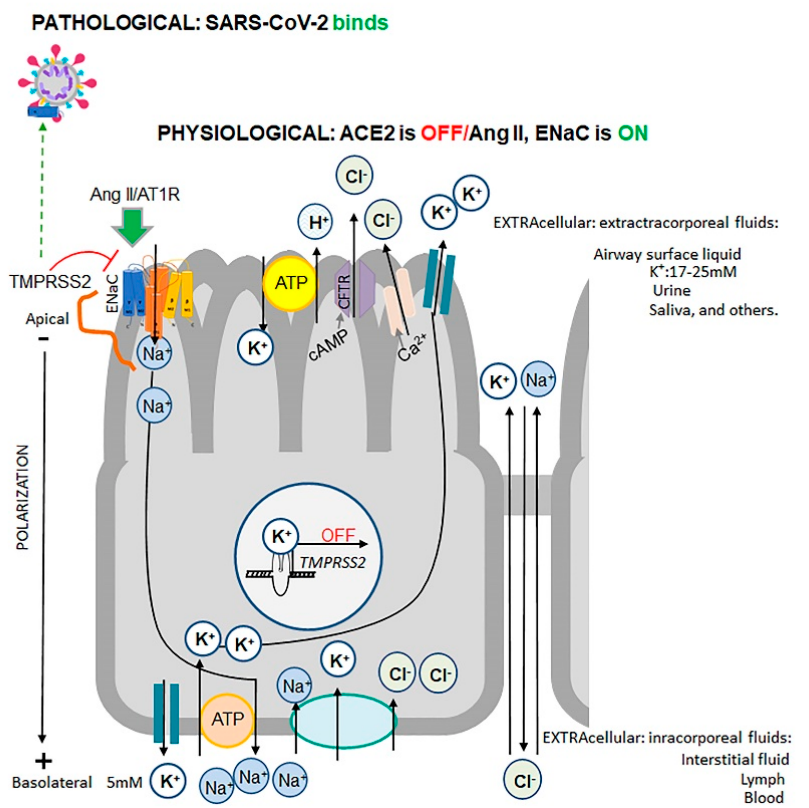
Figure 4. Pathophysiological regulation of ENaC in barrier cells, such as type II pneumocytes expressing ACE2 , TMPRSS2 [48], and ENaC [49]. These cells are a validated target of SARS-CoV-2 and exhibit viral particles in all investigated post-mortem lung tissues of COVID-19 patients [50], though other barrier cells, including ileal absorptive enterocytes, ciliated cells, and nasal goblet secretory cells, can also be infected [48]. Endothelial cells express ACE2, but not TMPRSS2 in the post-mortem lung tissues from COVID-19 patients [51]. Endothelial cells do not contain SARS-CoV-2 particles [50] but exhibit osmotic malfunctions: swelling, rupture, microthrombosis, and / or necrosis in these tissues [20,50], that may involve ENaC expressed in these cells [41]. Physiological regulation of ENaC activity is facilitated via feedback mechanism. In the ‘OFF’ state of ACE2, Ang II / AT1R (green arrow) induces mobilization and expression of the αβγ ENaC (blue, yellow, and orange shapes) to the apical side of barrier cells. Na + follows a gradient to the basolateral side where Na + / K + ATPase transporters mediate e ffl ux of Na + into the blood in exchange for K + . Na + / K + ATPase transporters, cystic fibrosis transmembrane conductance regulator (CFTR), and Na + -K + -Cl − cotransporter 1 (NKCC1) are expressed in pneumocytes and regulate alveolar fluid balance [52]. This Na + flow establishes a positive transcellular current (polarization) of ~2.7 ± 0.5 µ A / cm 2 . The K + follows a gradient to the apical side where its e ffl ux is mediated by multiple transporters leading to a 3–5-fold higher concentration of K + in airway surface fluid (15–27 mM K + ), compared to blood (5 mM K + ). TMPRSS2 (orange line shape) binding inhibits ENaC; however, TMPRSS2 is suppressed by K + ions bound to G quadruplex in the promoter region (nucleus). Intracellular loss of K + activates TMPRSS2 expression creating a potential feedback loop for inhibition of ENaC activity. Pathological regulation. The furin cleavage site on SARS-CoV-2 is homologous to human ENaC and therefore, can provide an alternative site for binding of TMPRSS2, which can cleave SARS-CoV-2 for replication. Host’s ENaC remains activated without inhibition by